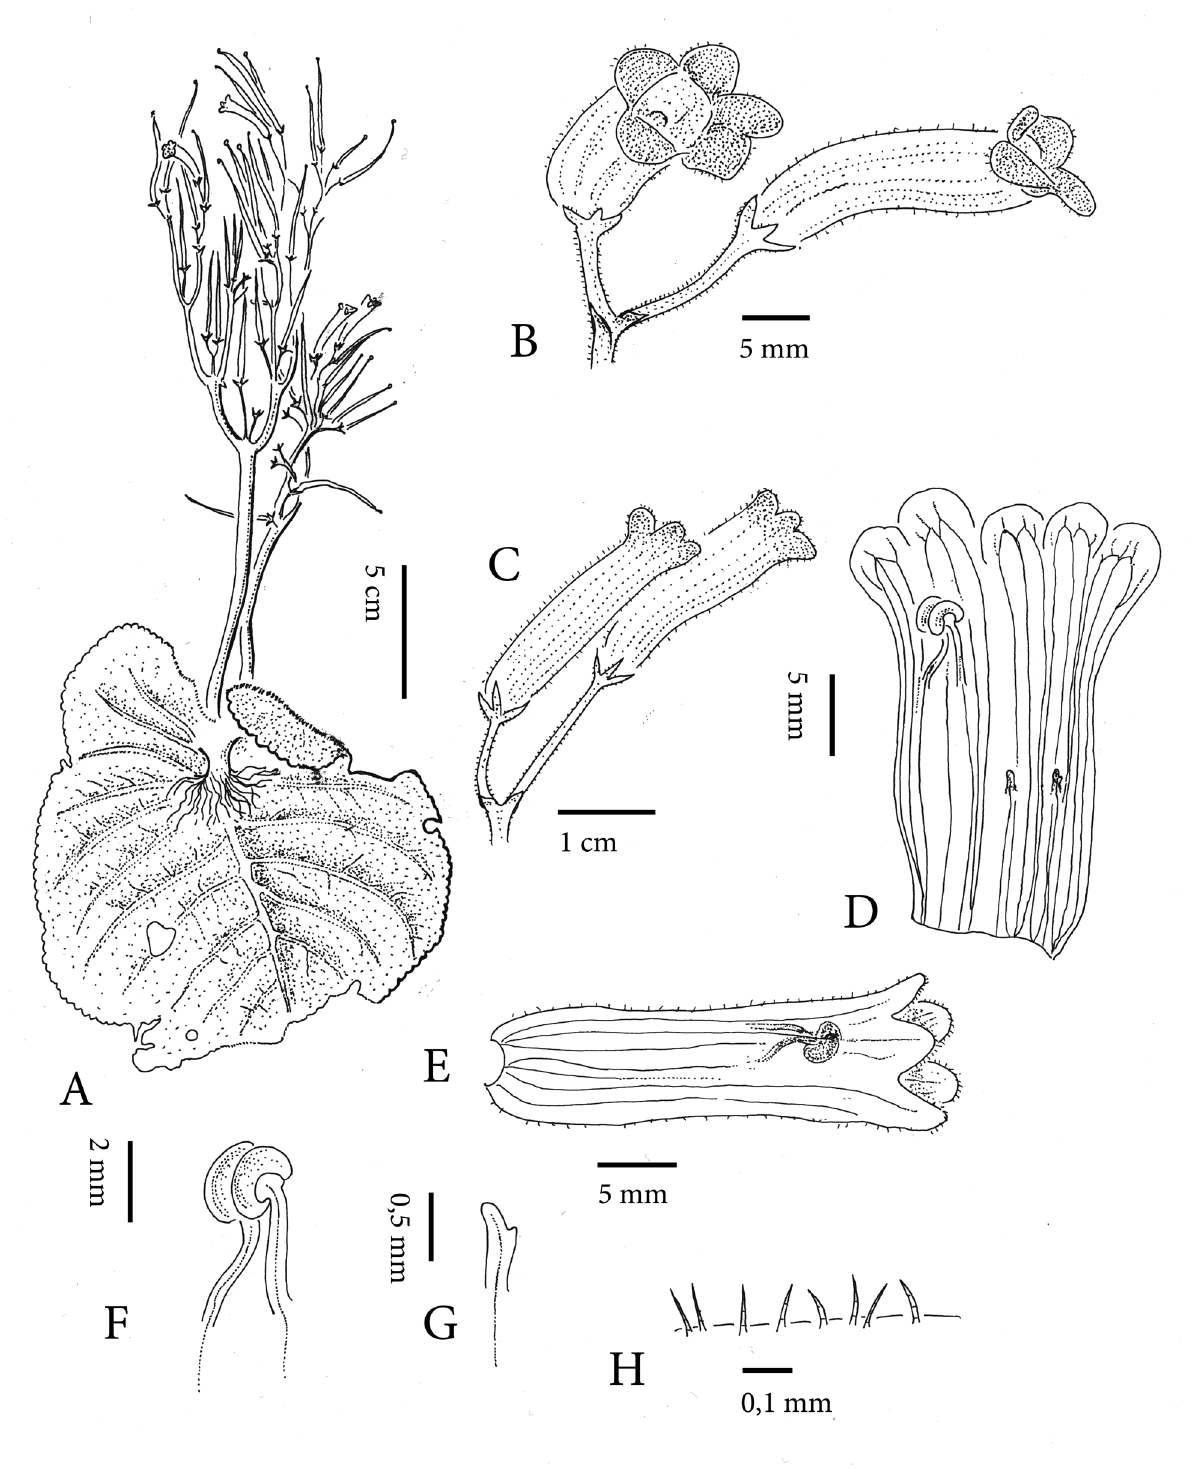
Figure 3 – Streptocarpus bampsii . A . Habit. B–C . Flowers. D . Corolla, dissected, showing stamens and staminodes. E . Corolla, lateral view. F . Stamens. G . Staminode. H . Hairs on corolla. From Bamps & Malaisse 8389 . Illustration by Eberhard